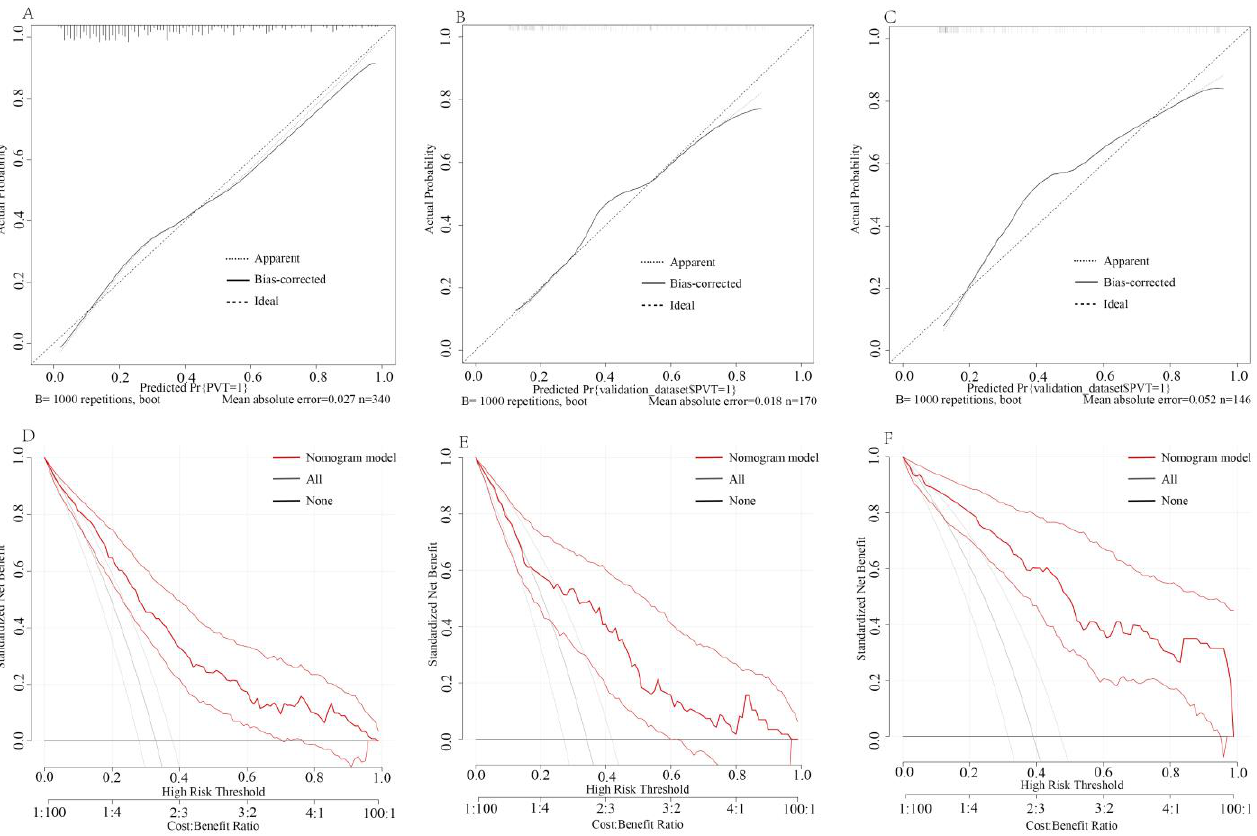
Figure 4. Calibration curves in the training cohort ( A ), internal validation cohort ( B ), and external validation cohort ( C ). The X -axis represents the predicted probability, and the Y -axis represents the actual probability of PVT. The black solid line indicates the bias correction with bootstrapping (1000 repetitions), and the dotted line represents the training, internal validation, and external validation cohort. The perfect prediction corresponds to the 45° dashed line. The decision curve analysis and 95% CI in training cohort ( D ), internal validation cohort ( E ), and external validation cohort ( F ). The horizontal black line represents the treatment of no patients, the slash gray solid line represents the treatment of all patients, and the red solid line represents the net benefit of the prediction model.